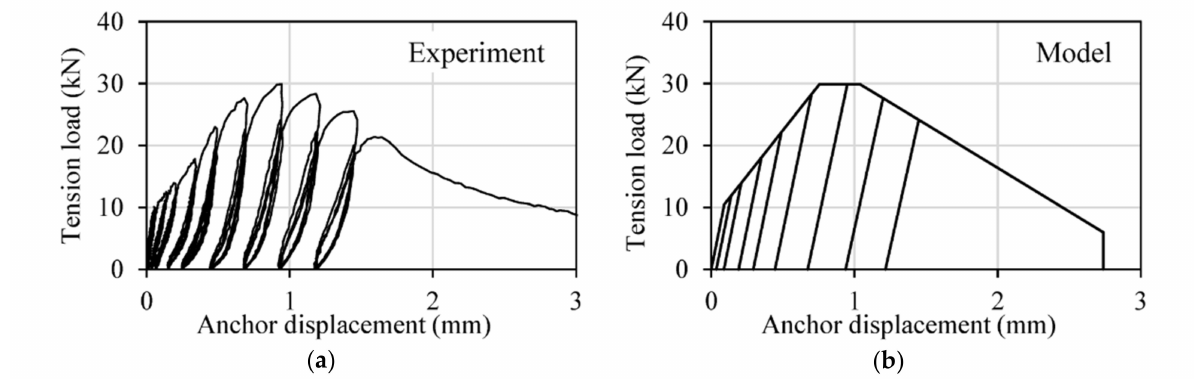
Figure 6. Load–displacement curves of: ( a ) a single bonded anchor (M16, h ef = 80 mm, C20/25, ∆ w = 0.8 mm) subjected to the displacement-controlled loading protocol for pulsating tension load; ( b ) idealization of the cyclic behavior of a single